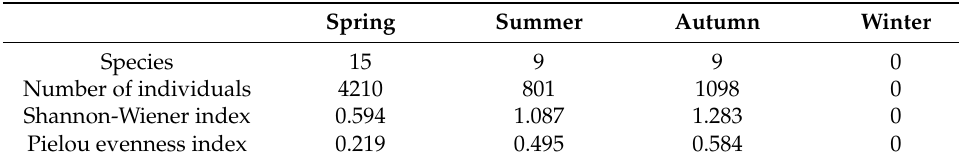
Table 1. Seasonal dynamics of bird diversity in Mangcuo Lake. Spring Summer Species